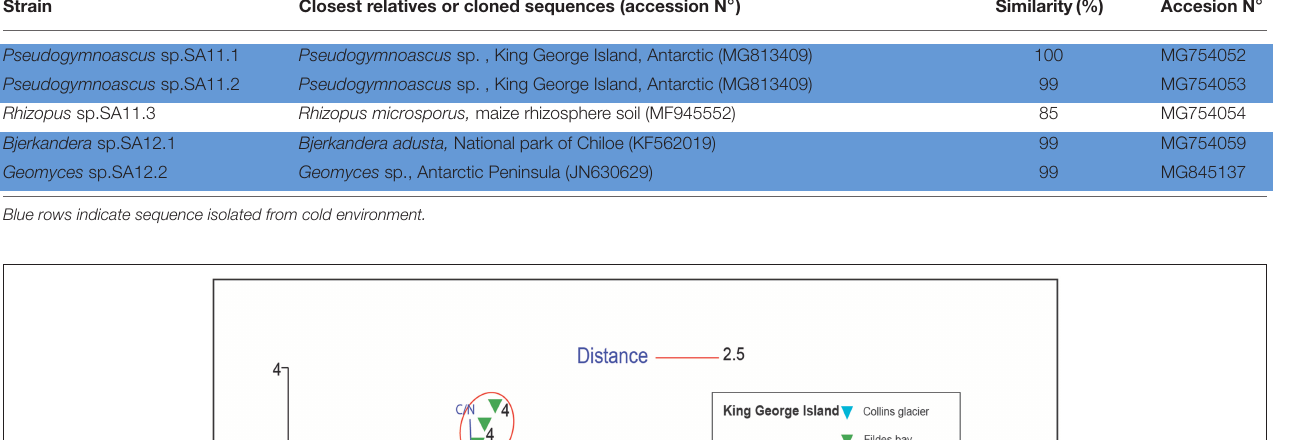
for 1 min; and 72 ◦ C for 3 min; with a final extension at 72 ◦ C